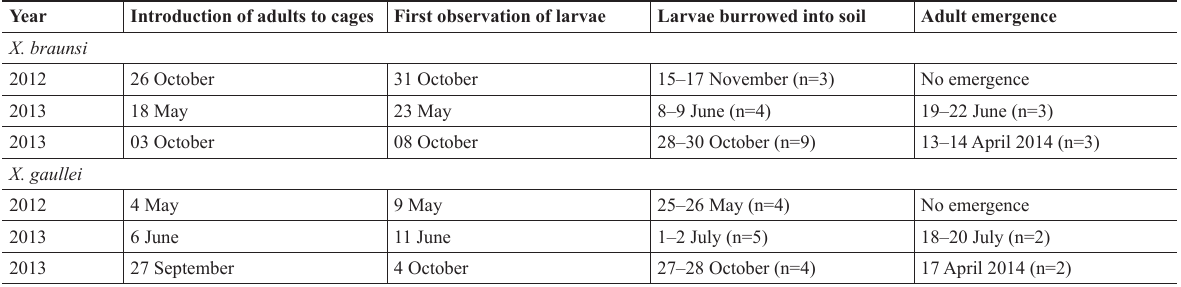
Table 1. Ex ova rearing chronologies of Xenapates braunsi and X. gaullei , using respectively Setaria barbata and Commelina communis as host plants, between 2012 and 2014. Numerous unsuccessful rearings are not listed. Introduction of adults to cages First observation of larvae Larvae burrowed into